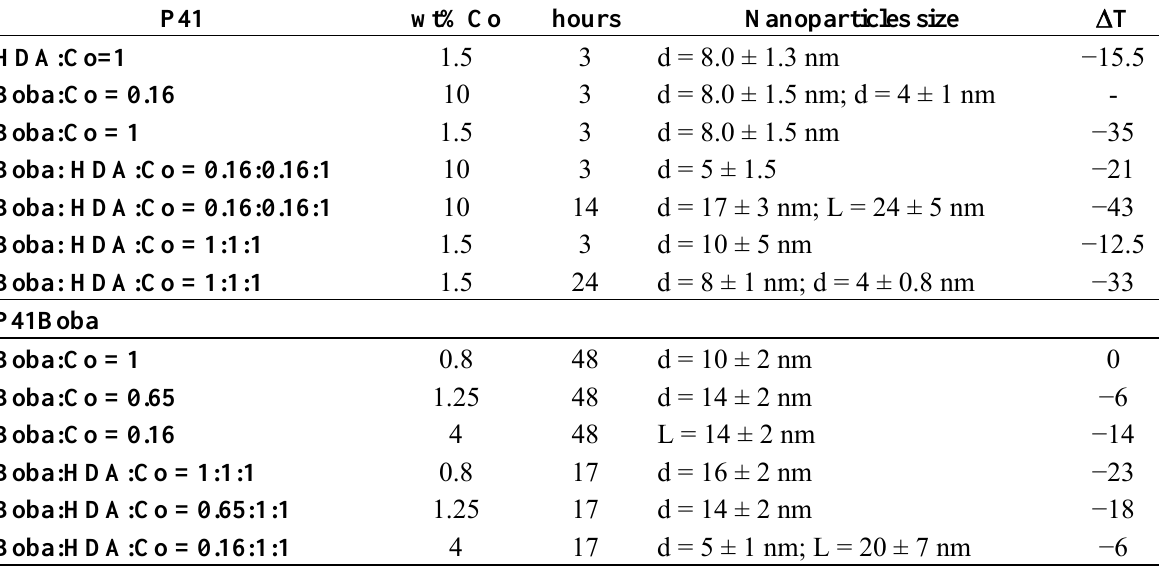
Table 1. Sample composition, wt% Co, time of reaction, nanoparticle sizes (d is the diameter of spherical nanoparticles and L is the length of the anisotropic ones) and isotropic to nematic transition temperatures changes of the composites as obtained by Polarized Optical Microscopy (POM) are reported in the case of the samples obtained in the in situ